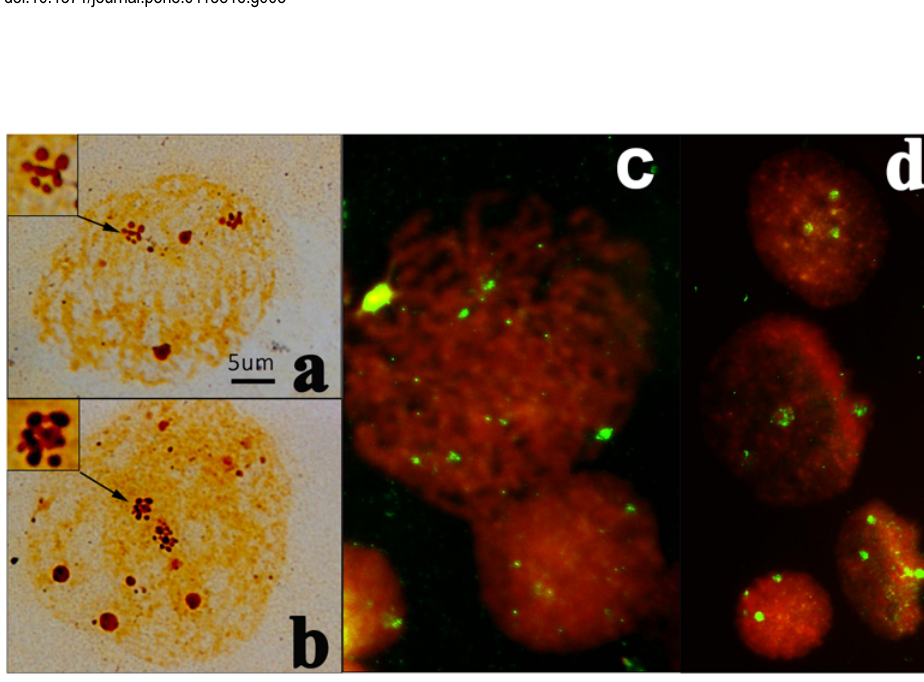
Fig 4. Ag-nucleoli and 18S gene of interphase cells. a: 4 NORs in prophase with 2 normal NORs and 2 conglomerate NORs composed of many small NORs. b: 5 NORs on metaphase with 2 NORs composed with of small NORs. c: 18S rDNA on prophase cell after FISH. d: FISH with 18S gene on metaphase cell.